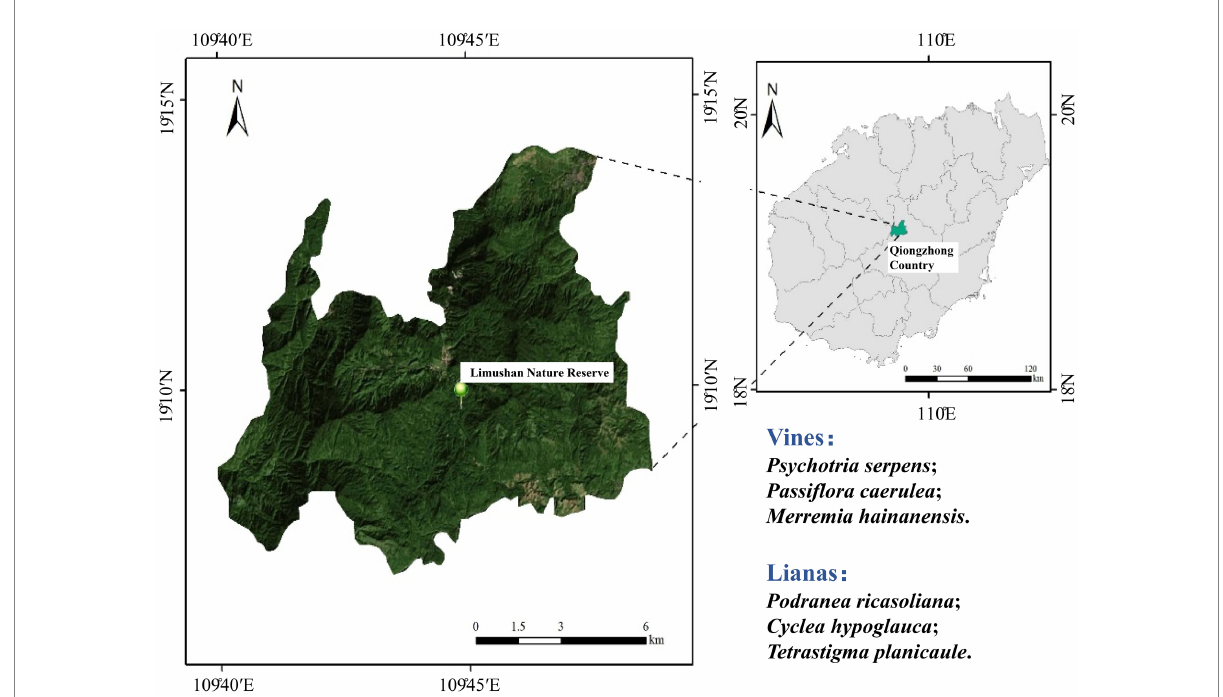
FIGURE 1 Location of Limushan Nature Reserve in Qiongzhong County, Hainan Province,